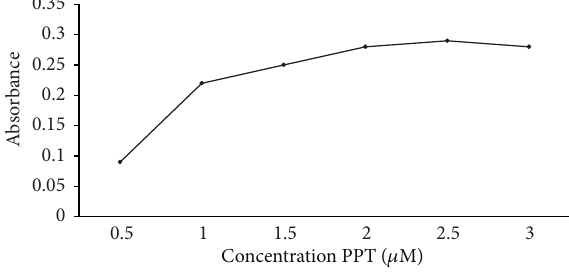
Figure 2: The effect of ligand (PPT) concentration on the ab- sorbance of the system, conditions: sample volume 5.0 mL contain- ing 1.0ng mL −1 of Zn(II), dispersive solvent 1mL ethanol, extraction solvent 100 𝜇 L CCl 4 containing PPT, extraction time